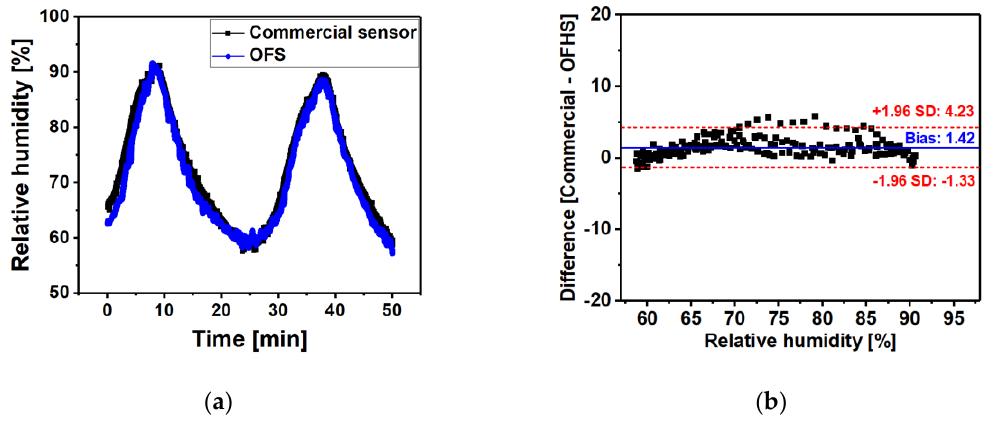
Figure 5. ( a ) The RH outputs from the 11 layer sensing probe (blue curve) and commercial sensor (black curve) measured in the climatic chamber. ( b ) Bland-Altman plot showing the di ff erence between RH measurements from sensing probe and commercial humidity sensor. The x-axis and y-axis show the relative humidity and the di ff erence (Commercial - OFHS) of the RH reading from the two sensors, respectively. The red dashed lines represent the 95% limits of agreement = 1.96SD of the di ff erences between two sensors.